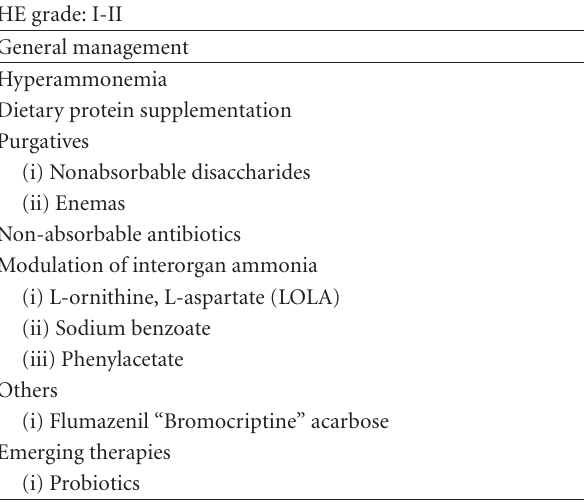
Table 1: Treatment stratagems used in